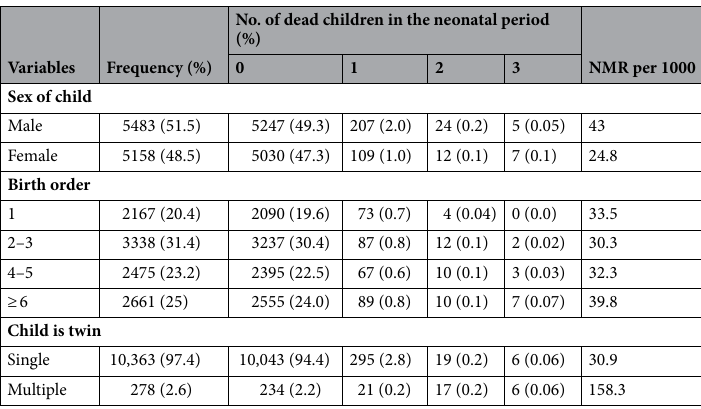
Table 3. Neonatal factors.